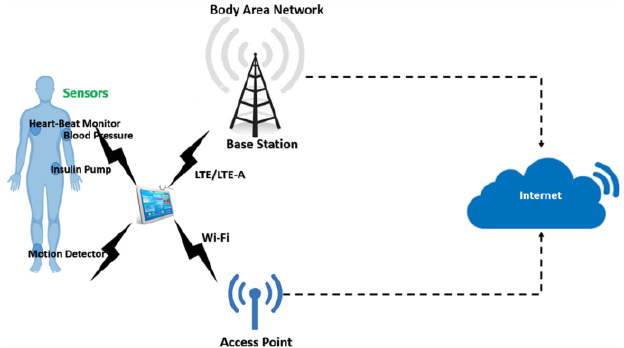
Figure 29. Body area network [114]. Reprinted with permission from ref. [114]. 2020 Elsevier. Abbreviations used: LTE, Long Term Evolution; and LTE-A, Long Term Evolution-Advanced.